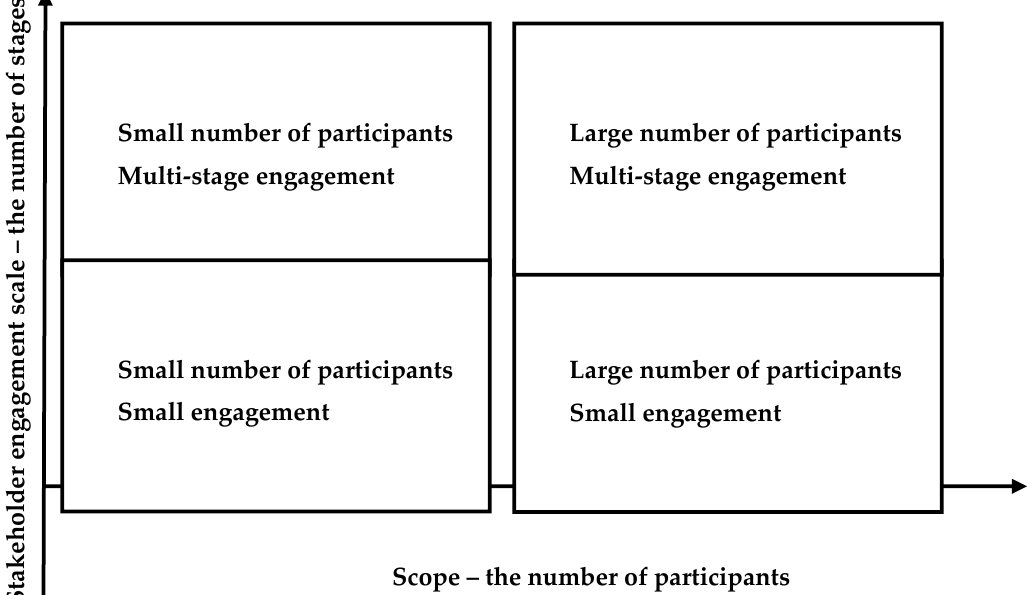
Figure 1. Scale and scope of stakeholder engagement. Source: Own study.